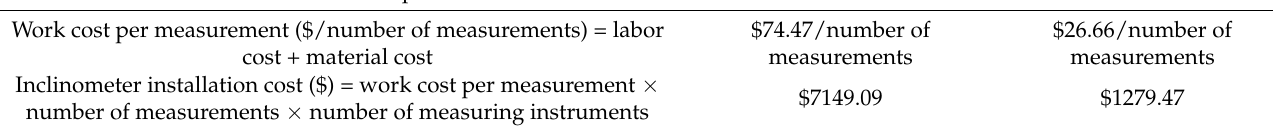
Figure 15. The inflation rate in Korea over the past 10 years [38] and the bank deposit interest rate [39] were used as discount rates for the LCC analysis. The average inflation rate over the past 10 years was used for the LCC analysis, and a sensitivity analysis was conducted regarding the discount rate for the inflation and bank deposit interest rates range (0.90%–3.43%) over the past 10 years (Figure